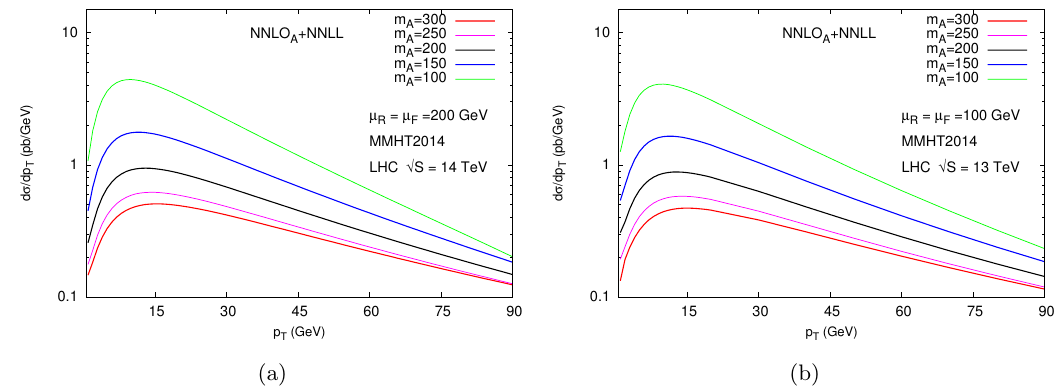
Figure 8 . Pseudo-scalar Higgs mass variation at NNLO A +NNLL for (a) 14 TeV and (b) 13 TeV. Pseudo-scalar Higgs mass variation: in (cid:12)gure 8(a) and (cid:12)gure 8(b) we show